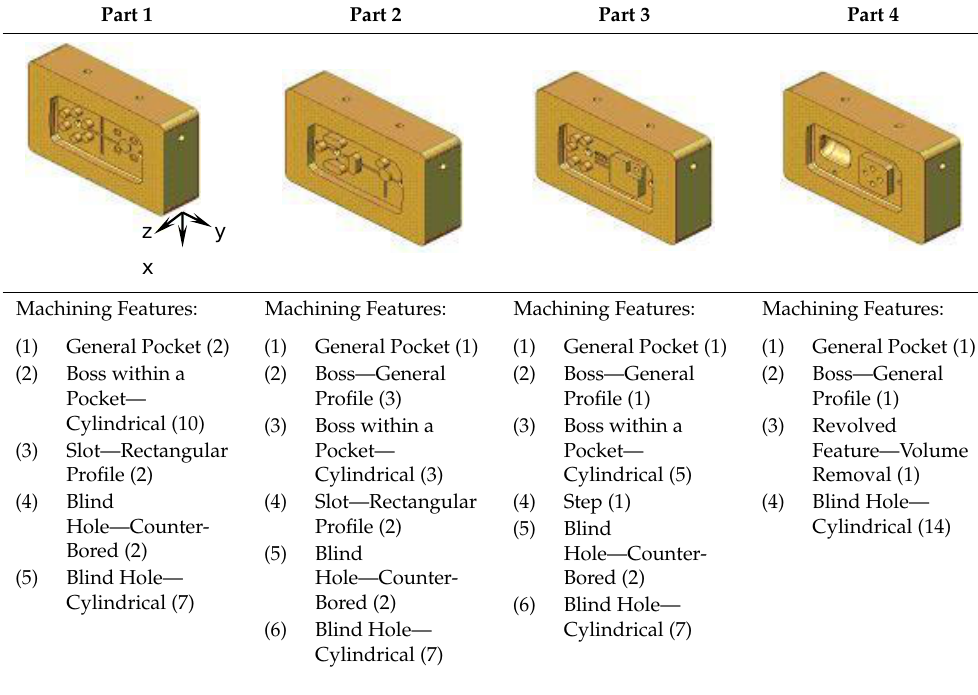
Table 1. Machining features extraction.